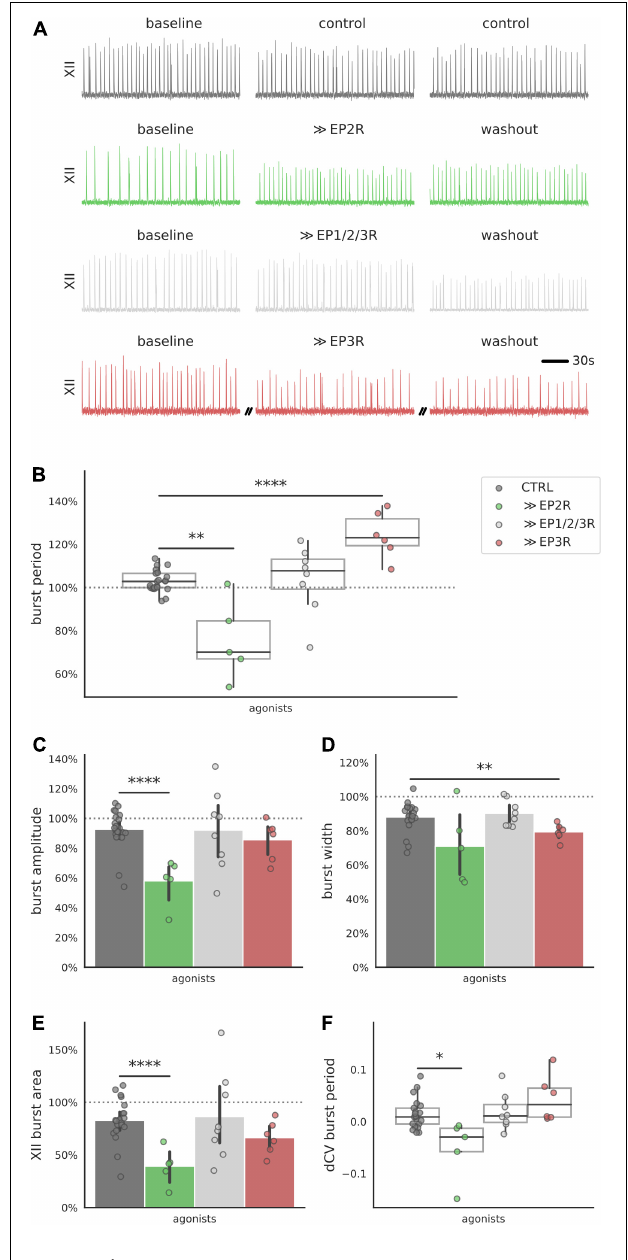
FIGURE 4 | Integrated XII motor output in preBötC slices after exposure to prostanoid receptor agonists. (A) Examples of integrated hypoglossal motor output (XII) of slices exposed to EP2R agonist Butaprost (500 nM), EP3R agonist Sulprostone (1 µ M) and non-selective prostanoid receptor agonist 11-deoxy PGE1 (10 nM) (150 s shown per condition). (B) Activating prostanoid receptors with selective agonists modulates burst period of XII motor output. Exposure to EP2R agonist Butaprost decreases burst period (–28% below control, p < 0.01), while EP3R agonist Sulprostone increases burst period (+21% above control, p < 0.0001). Non-selective prostanoid receptor agonist 11-deoxy PGE1 does not change the burst period. (C) EP2R agonist Butaprost decreases average burst amplitude (–35% below control, p < 0.001). (D) EP3R agonist Sulprostone decreases burst width (–9% below control, p < 0.01). (E,F) EP2R agonist Butaprost decreases XII burst area (–44% below control, p < 0.001) and the CV of the burst period (–0.07 below control, p < 0.05) ( ∗ p < 0.05, ∗∗ p < 0.01, ∗∗∗∗ p <